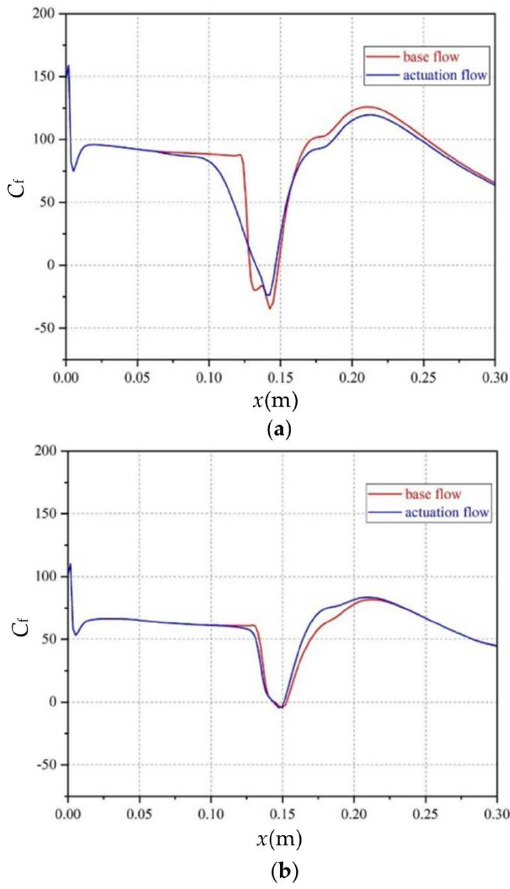
Figure 24. Skin friction coefficient curve at different spanwise cross sections: ( a ) z = 0.025 m; ( b ) z = 0.054 m.